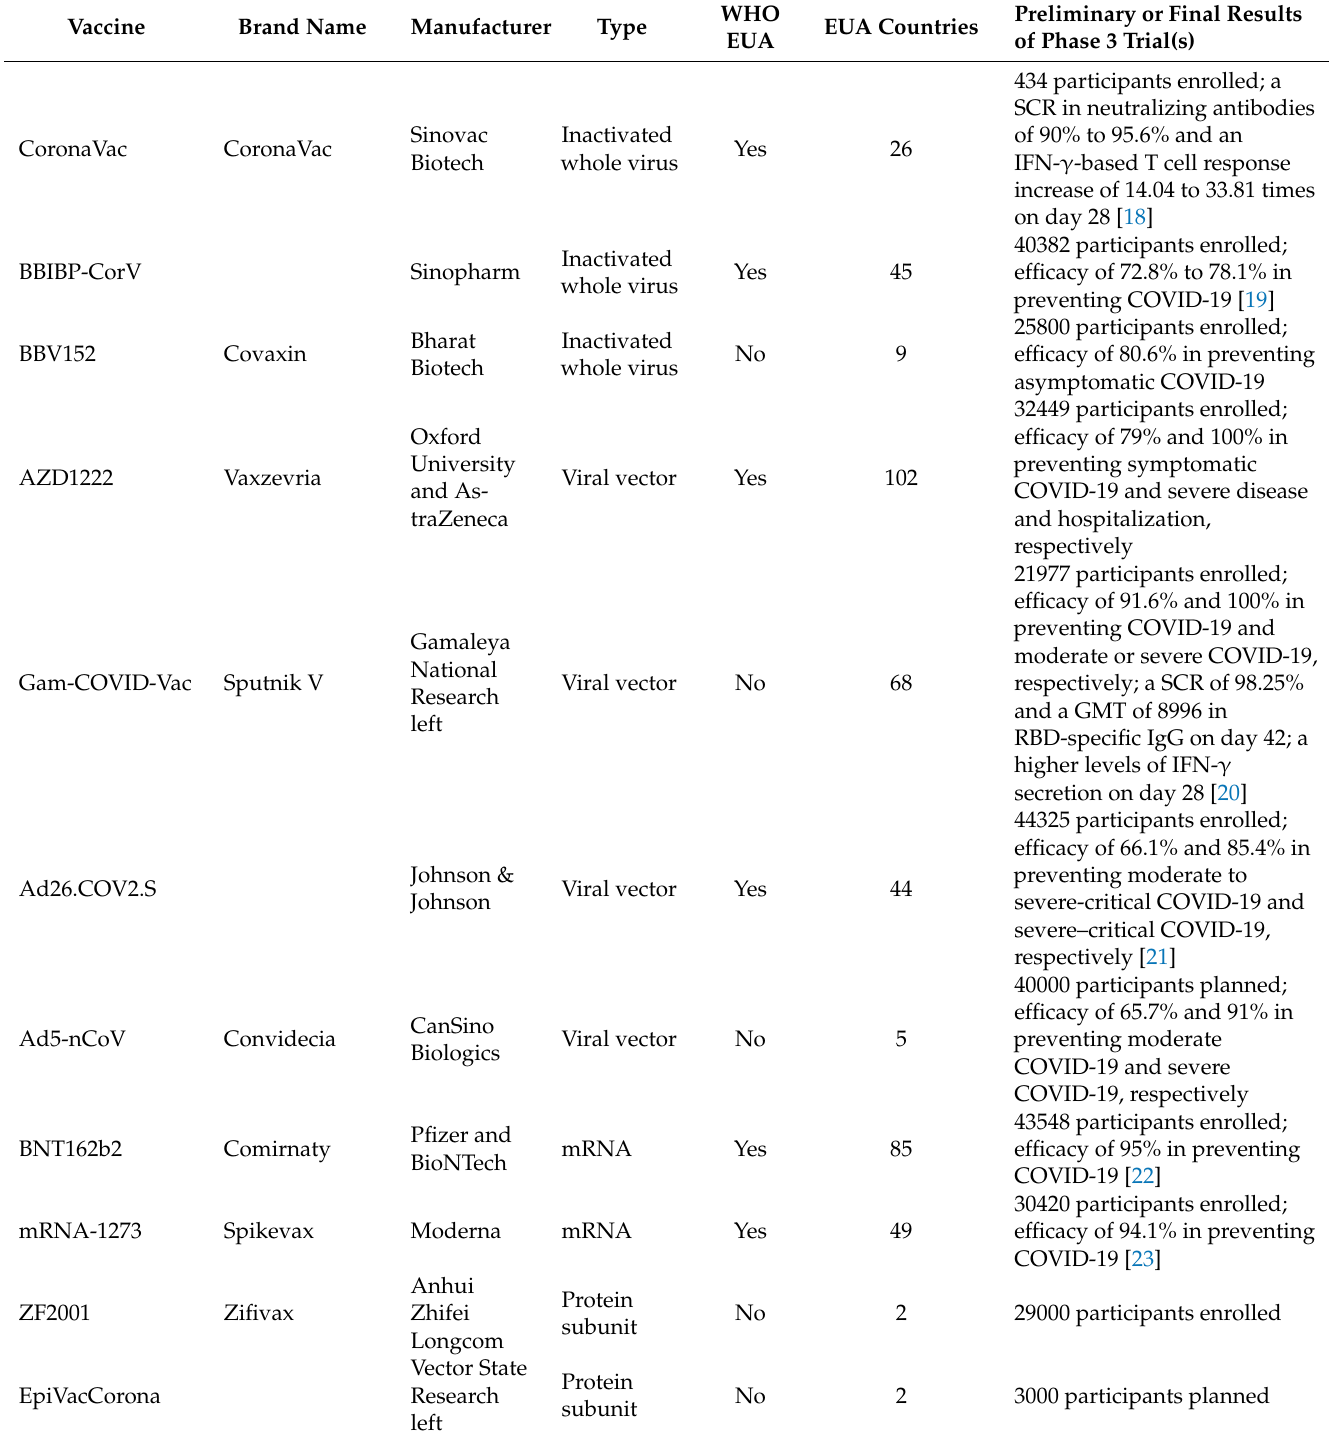
Table 1. Progress of COVID-19 vaccines acquiring multinational emergency use